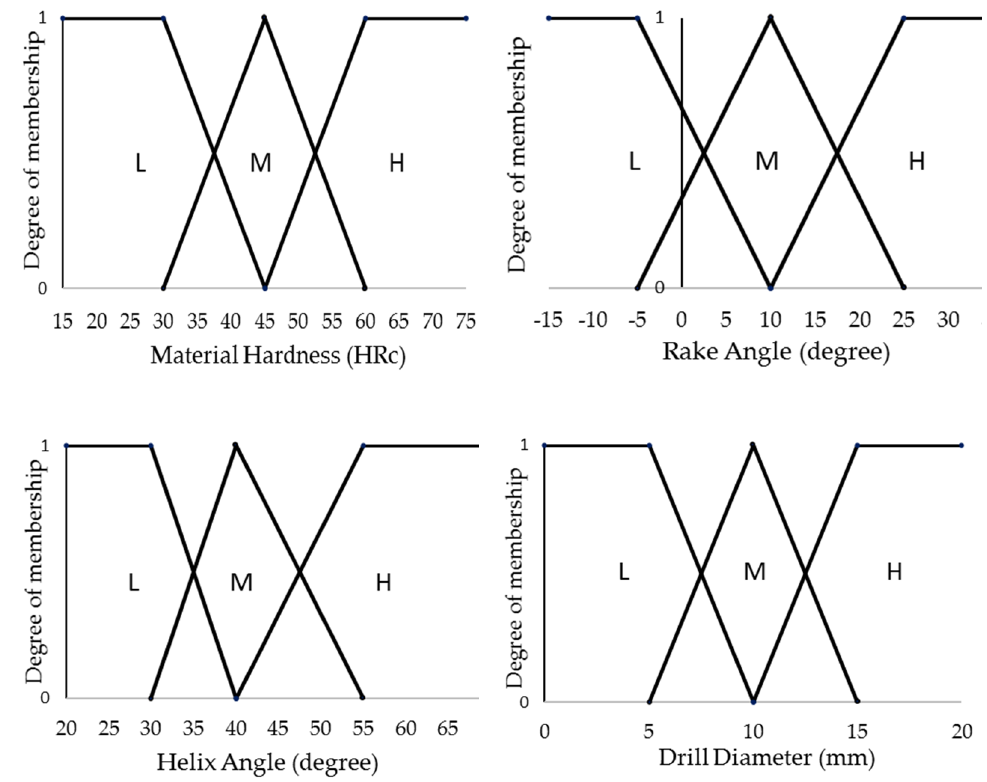
Figure 1. Fuzzy set for the impact of a machining control parameter on a sustainability measure.